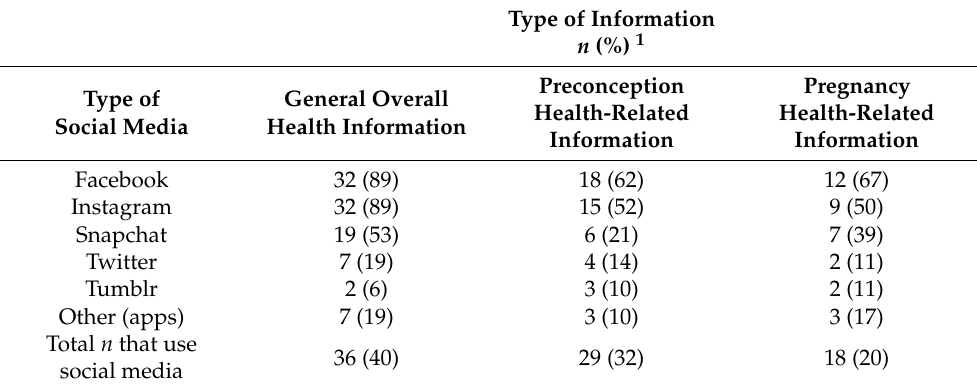
Table 2. Types of social media that women use for general, preconception, and pregnancy health- related information.